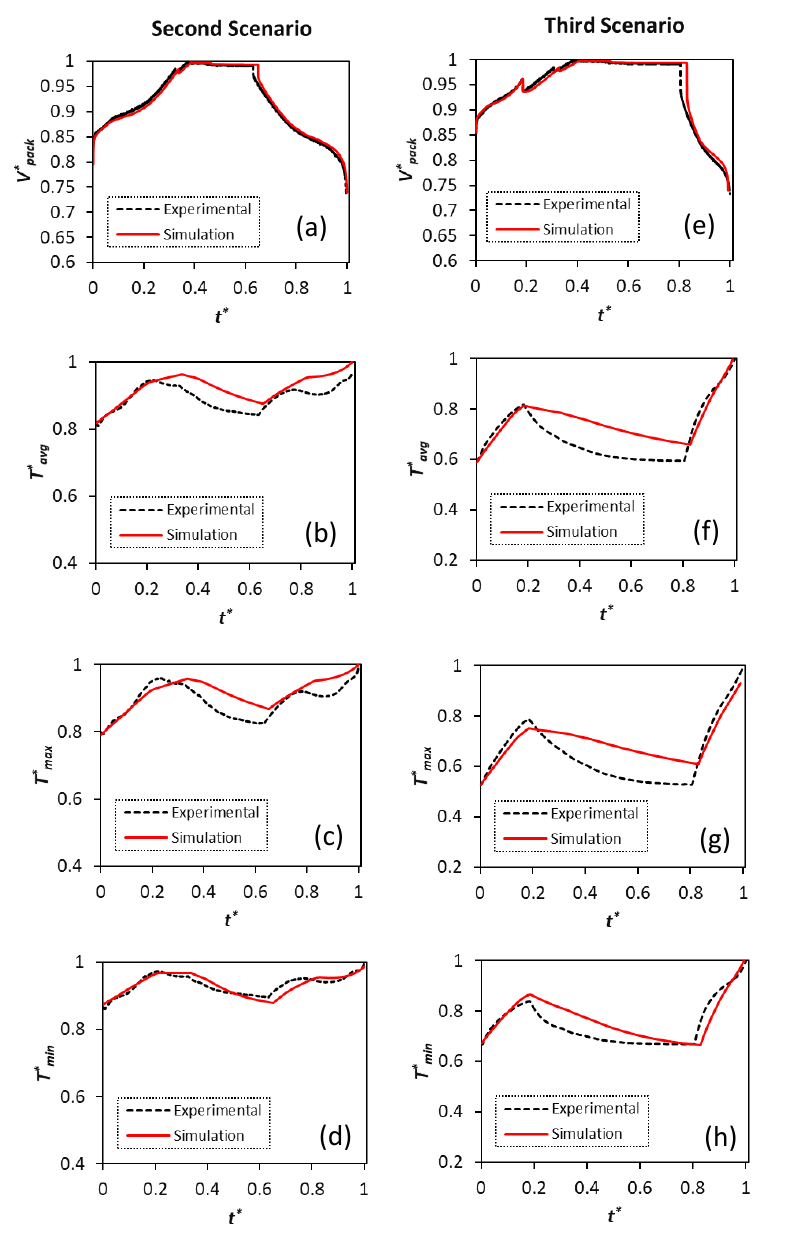
Figure 12. Module-to-module discretization battery pack model evaluation. ( a – d ): second scenario (C/2 + C/3 CC charge, CV charge, rest, C/2 discharge); ( e – h ): third scenario (1.1 C + C/2 + C/3 CC charge, CV charge, rest, 1.5 C